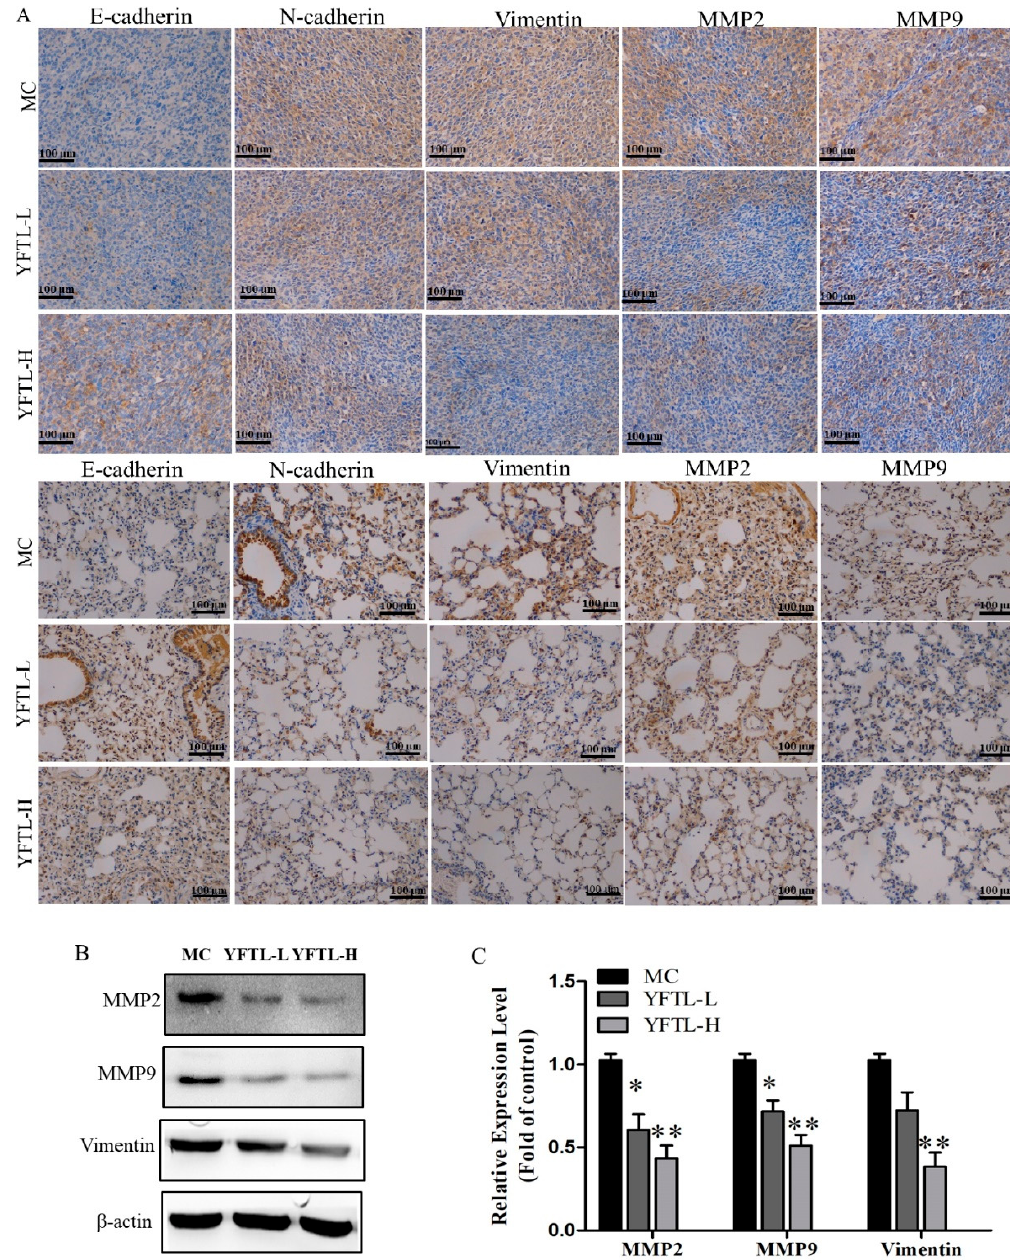
Effect of YFTL on EMT in tumor and lung tissues of Lewis lung cancer mice. ( A ) Representative photomicrographs of immunohistochemistry of MMP-2, MMP-9, E-cadherin, N-cadherin and Vimentin in tumor tissues and lung tissues. Scale bars are 100 µ m. ( B ) A representative band of MMP-2, MMP-9, and Vimentin protein expression in tumor tissues by Western blot analysis. (C) Relative protein level of MMP-2, MMP-9, and Vimentin in tumor tissues. Data are expressed as a histogram of mean ± SD of three independent experiments, * p < 0.05, and ** p < 0.01 vs. the MC group.